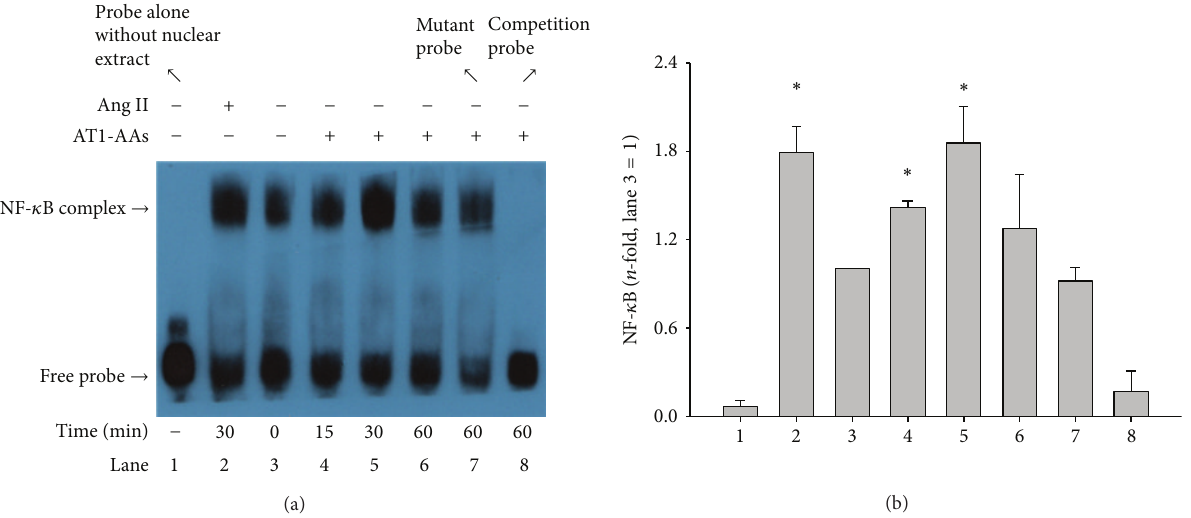
Figure 6: Activation of NF- 𝜅 B by EMSA analysis after AT1-AAs stimulation in endothelial cells. After incubating cells with angiotensin II (0.1 𝜇 M) for 30min and AT1-AAs (0.1 𝜇 M) for 0, 15, 30, and 60 min, activity of NF- 𝜅 B in endothelial cells was determined by EMSA analysis (panel (a)). Lane 1: probe alone without nuclear extract; lane 2: incubation with angiotensin II for 30min; lane 3: control (before incubation with AT1-AAs); lane 4: incubation with AT1-AAs for 15min; lane 5: incubation with AT1-AAs for 30 min; lane 6: incubation with AT1-AAs for 60 min; lane 7: mutant oligonucleotide to test the specificity of the method; lane 8: 200-fold molar excess of unlabeled NF- 𝜅 B oligonucleotide as a competitive inhibitor. Data were summarized from 5 independent experiments (panel (b)); ∗ 𝑃 < 0.05 versus control group (lane